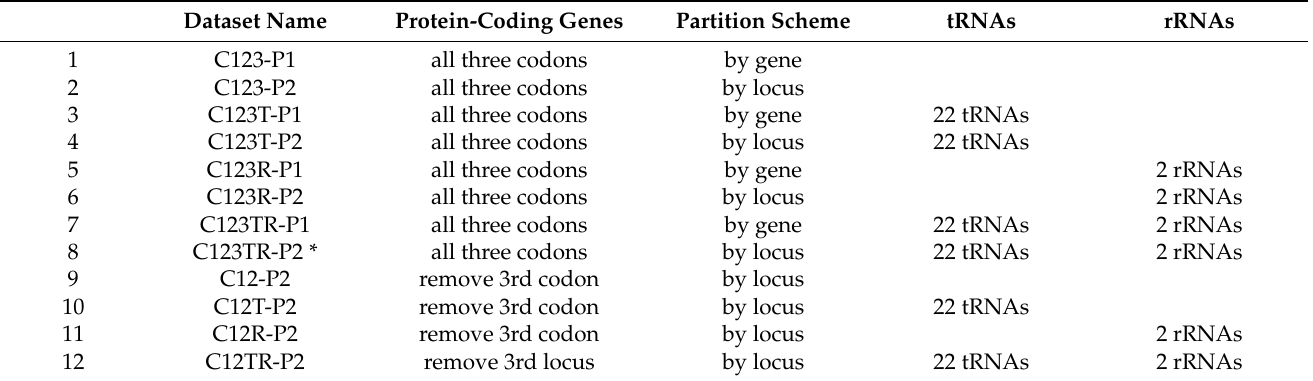
Table 2. Datasets used for Muscidae tree reconstruction. The asterisk indicates the best dataset for phylogenetic analyses in our